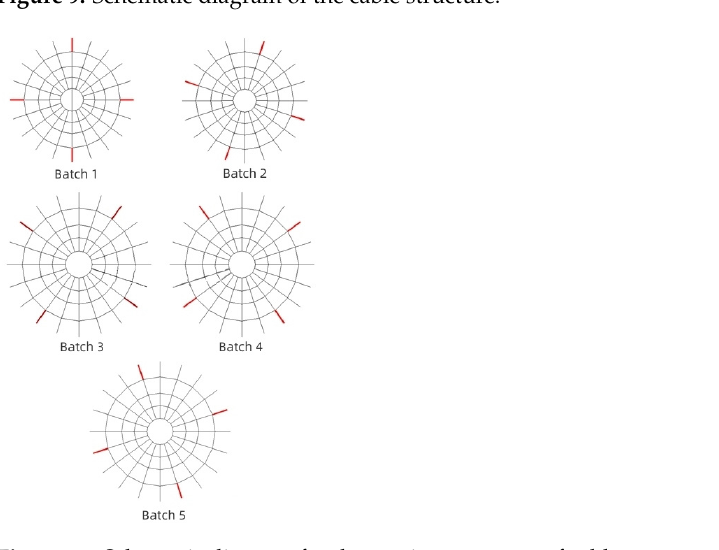
Figure 10. Schematic diagram for the tension sequence of cable structure.